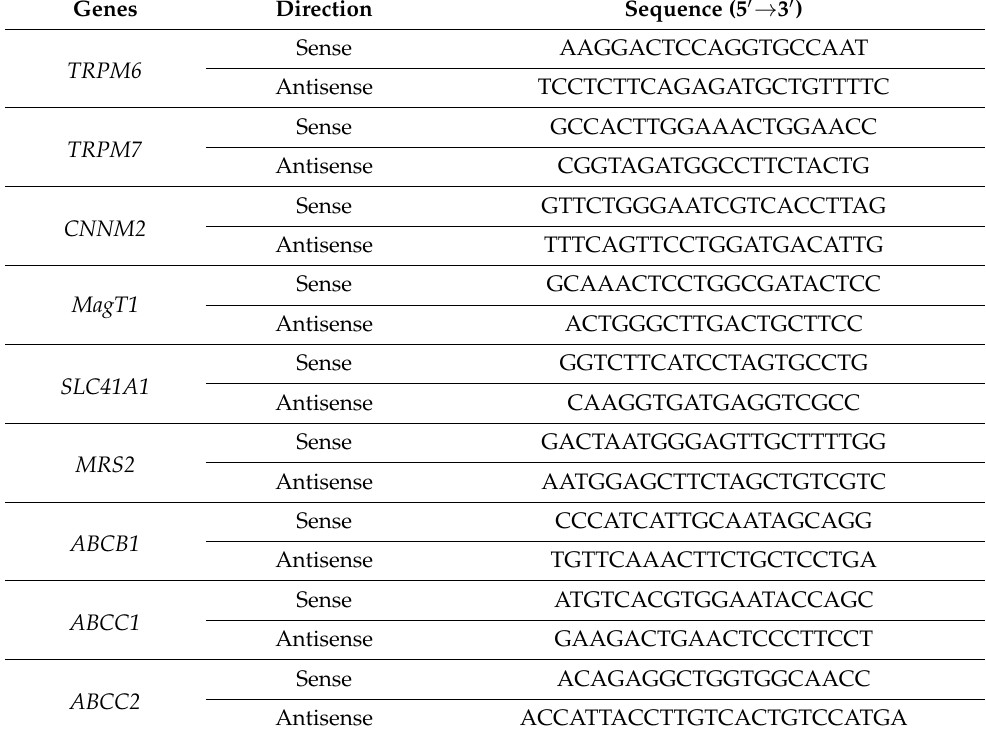
Table 1. Primer pairs for real-time PCR.